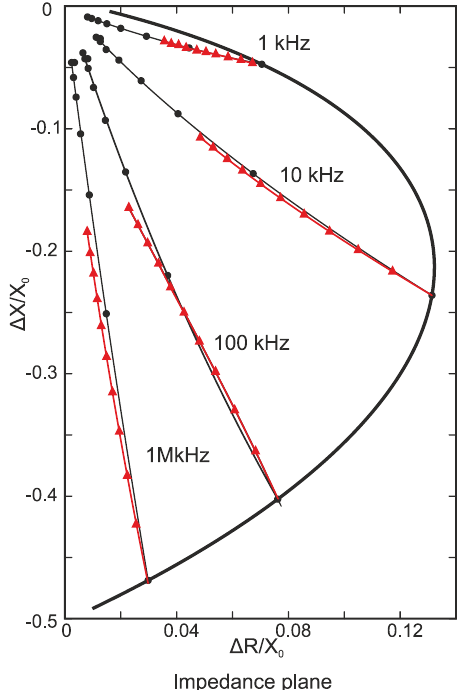
Figure 11. Lift-off in steps of 0.1 mm (triangle) and tilt in steps of 10  (round) for a normalized impedance plane (adapted from